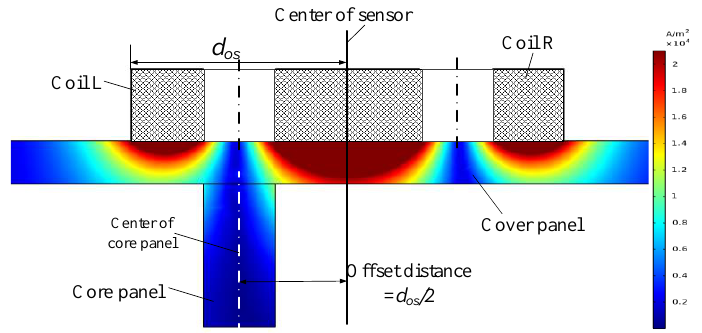
Figure 8. Schematic diagram while the offset distance between the centers of sensor of core was d os /2 .